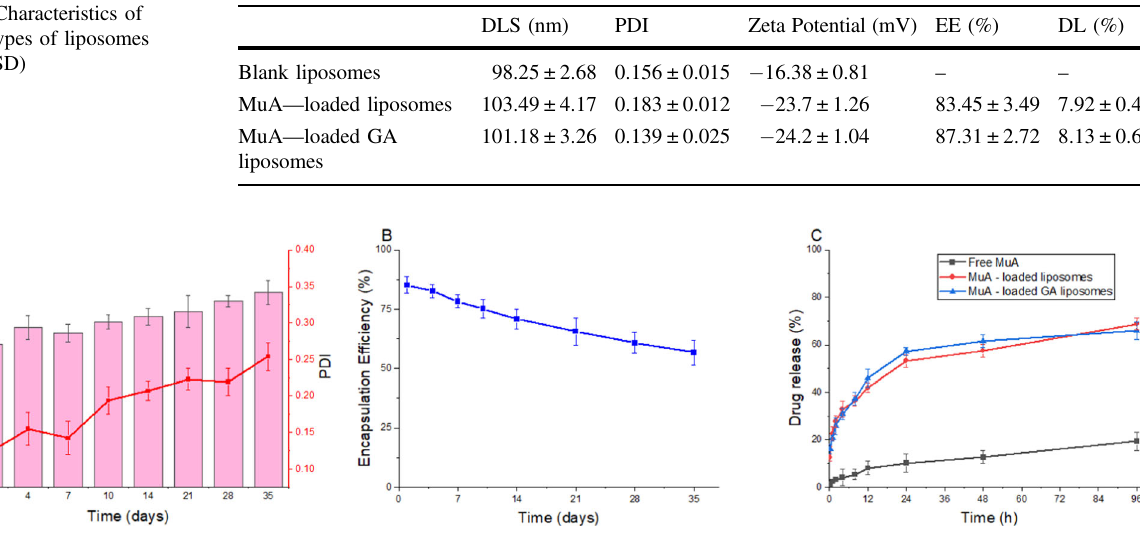
release properties of free drug and liposomes. Data are presented as the mean ± SD ( n = 3)